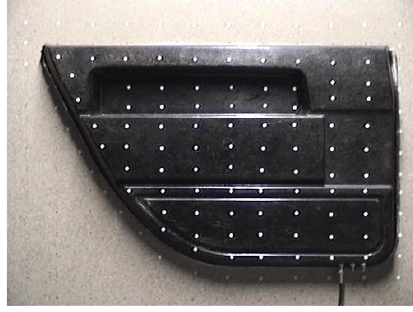
Figure 6. Image of the side door panel with marked positions of the measuring points.